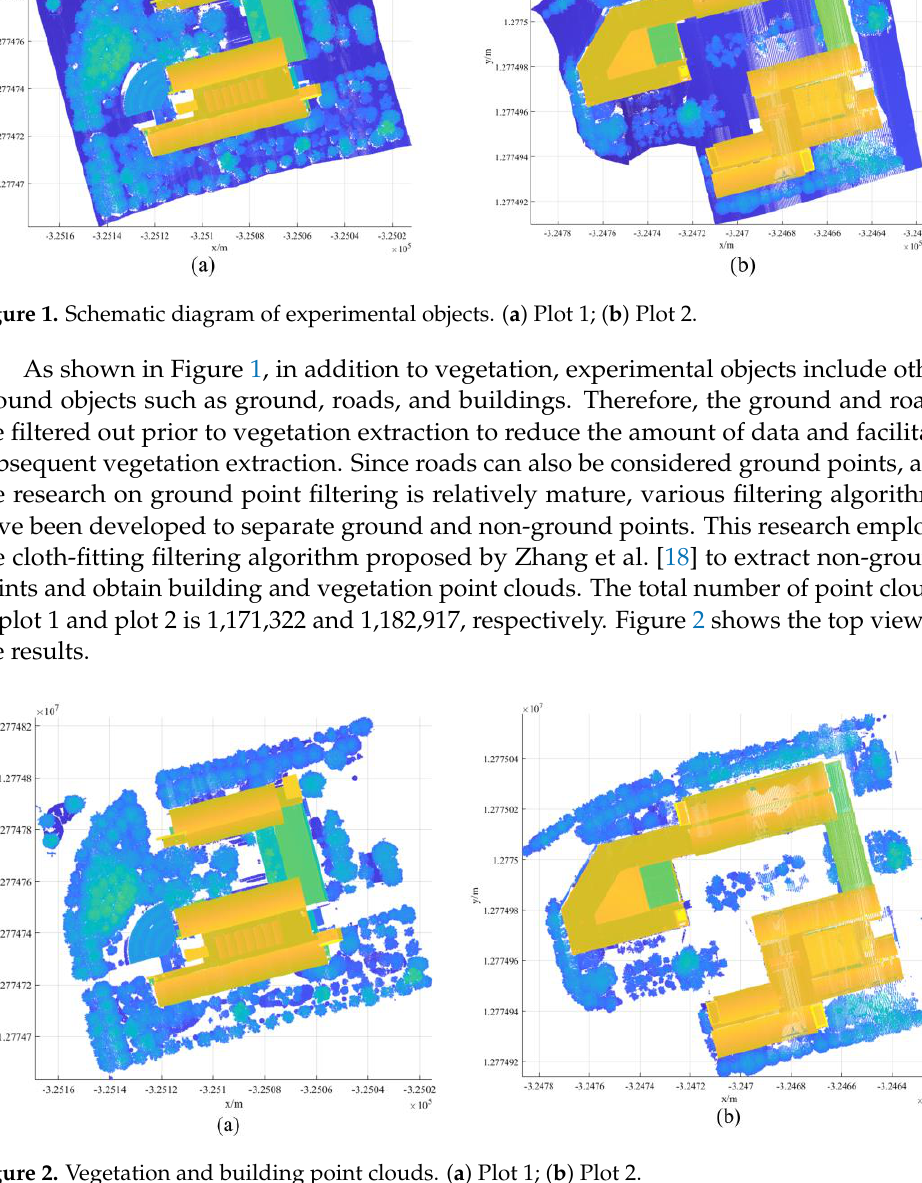
Figure 2. Vegetation and building point clouds. ( a ) Plot 1; ( b ) Plot